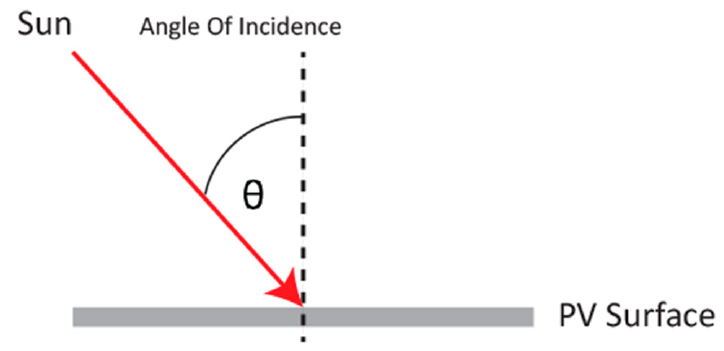
Figure 3. Representation of angle of incidence.